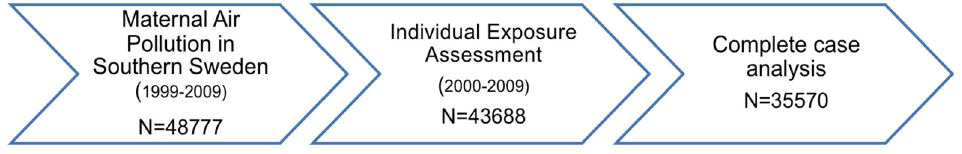
Figure 2. Flowchart of the study.